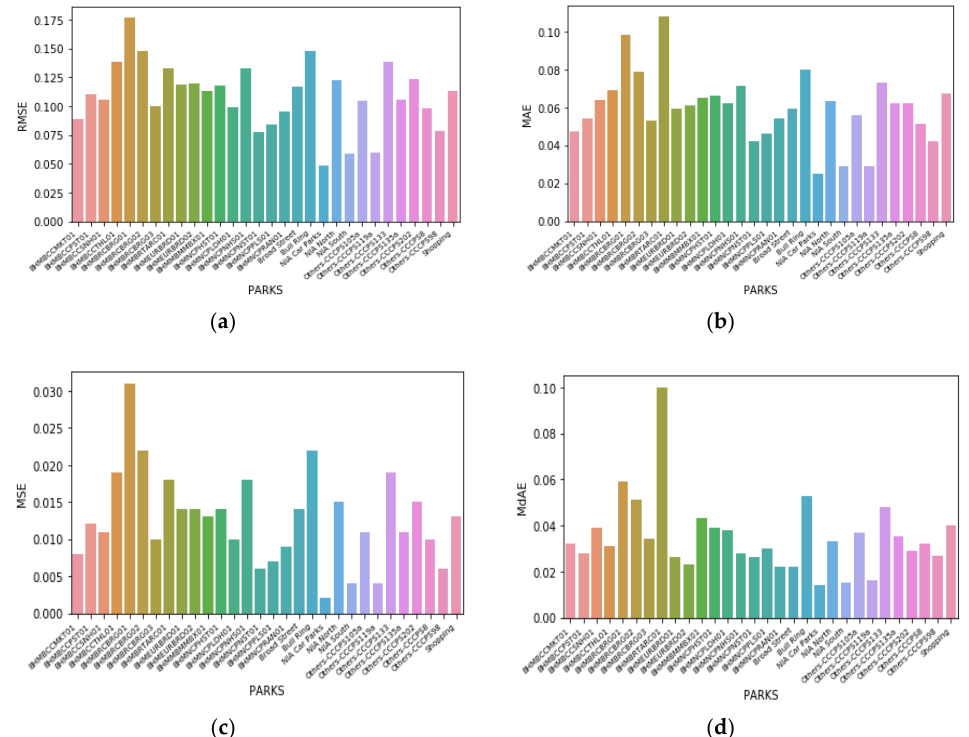
Figure 7. Parking availability prediction error rate against each parking location using loss functions: ( a ) root mean square error (RMSE), ( b ) mean absolute error (MAE), ( c ) mean squared error (MSE), ( d ) MdSE.